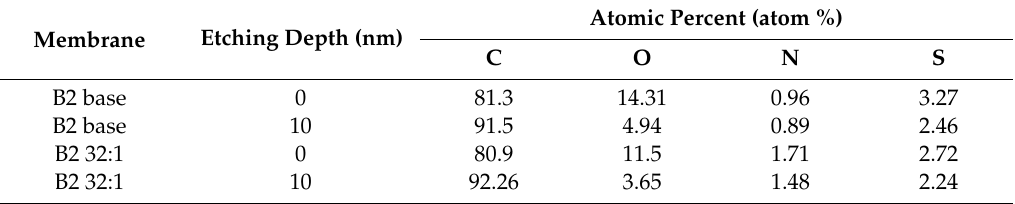
Table 3. Elemental percentage of B2 base and B2 32:1 membranes obtained from XPS spectra. Membrane Etching Depth